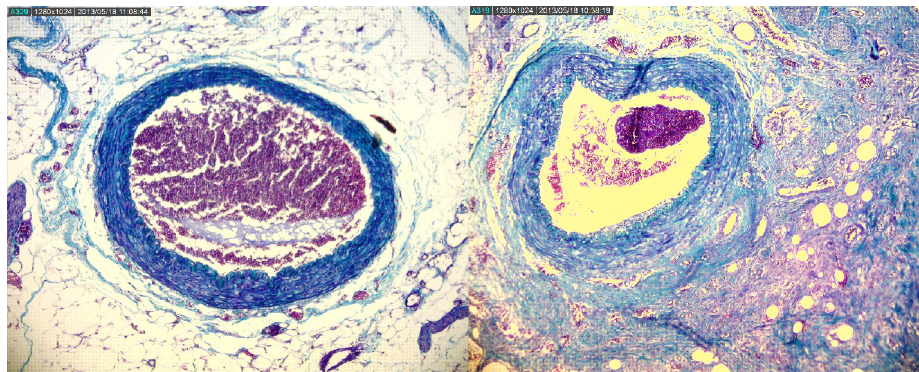
Fig. 2 - Fibrosis absent/mild in polyurethane group (left) and moderate/severe in the cyanoacrylate group (right) stained with Masson’s